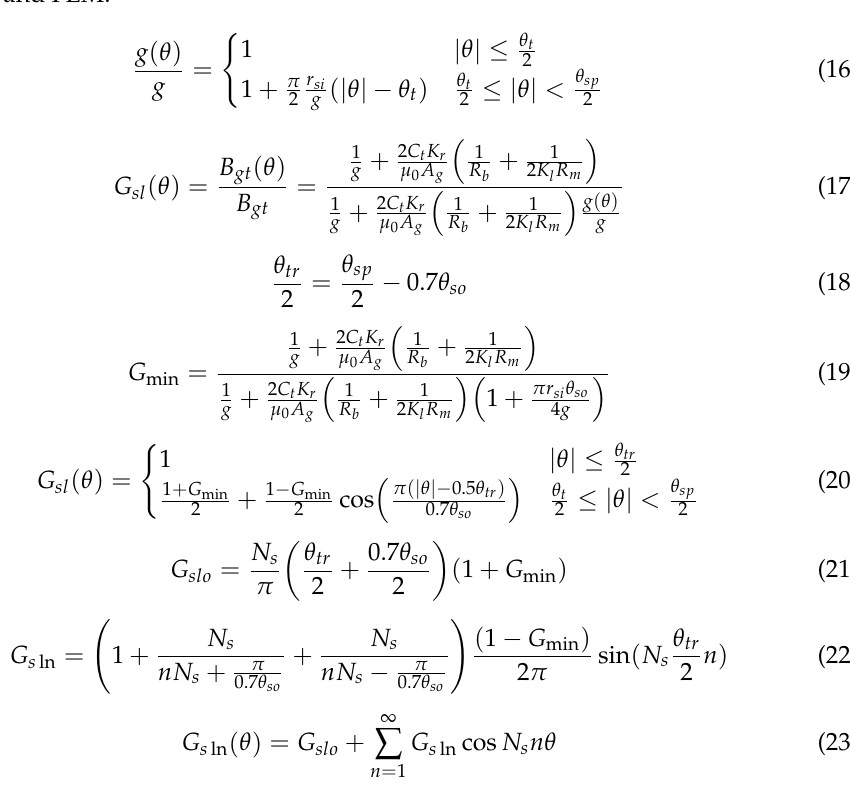
Figure 6. Air gap flux line distribution per slot when there are slots . The function of the air gap length of the slot-opening region is expressed as Equation (16). In order to derive the function of the slot factor, the magnetic circuit equation obtained by functionalizing the air gap length is divided into the magnetic circuit equation before functionalization. If these equations are rearranged, the function equation of the slot factor is derived as Equation (17). However, this slot factor function does not reflect the satura- tion of flux density of the shoe part, as shown in Figure 7. Therefore, by applying the slot- opening range of Hanselman, the slot opening is changed to 0.7, which is larger than the actual 0.5, and the function is changed to Equation (18) [14]. The final slot factor function is derived as Equations (19) and (20). Applying this expression to the Fourier series yields Equations (21)–(23). Figure 6b shows the slot factor derived through the HMEC and FEM.